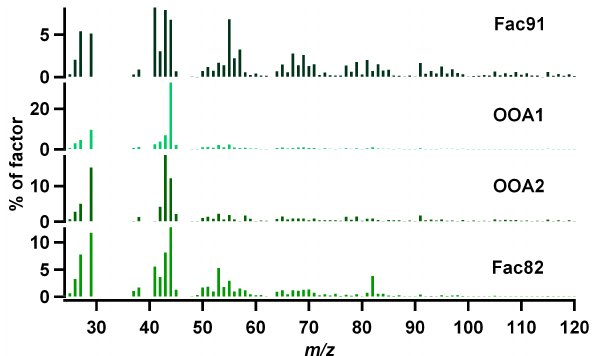
Fig. 6. Factor spectra for the four factor, fpeak= − 1 solution of PMF analysis of organic mass spectra. From top to bottom, spectra are 91Fac, OOA1, OOA2 and 82Fac.